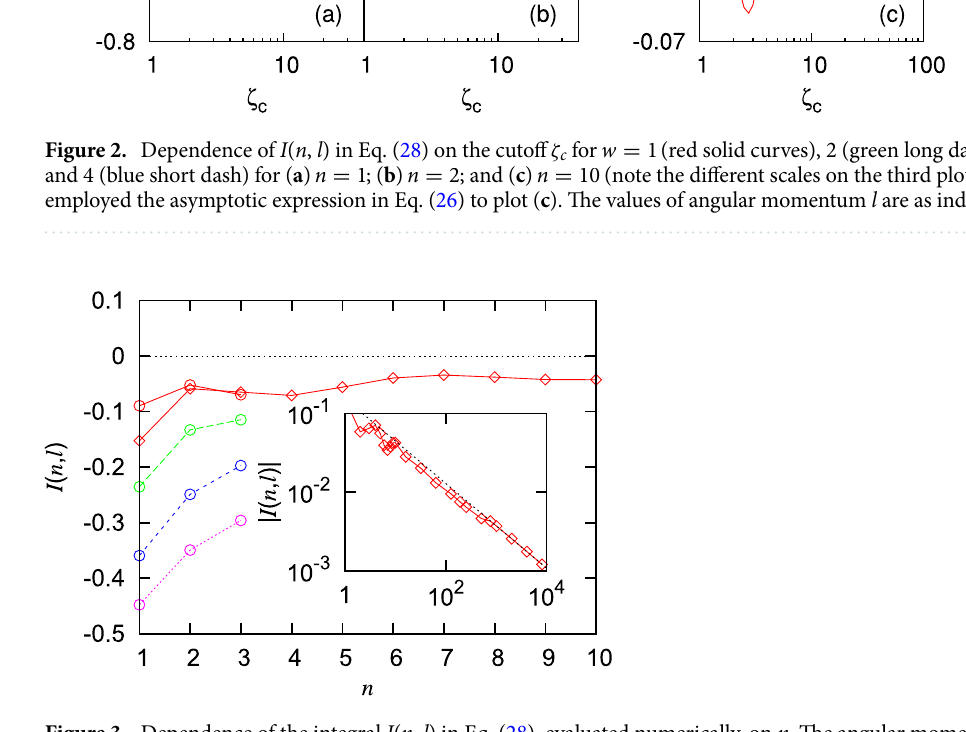
Figure 3. Dependence of the integral I ( n , l ) in Eq. (28), evaluated numerically, on n . The angular momenta of 2, 3, 4 and 5 (solid, long-dashed, short-dashed and dotted lines, respectively). Circles the instabilities are l = 1, 2 and 3. Diamonds were obtained using represent values obtained using the effective potentials, v n (ζ) for n = 2 case. The straight the asymptotic formula in Eq. (26). The inset shows the behaviour at very large n for the l = 800 . The fitting parameters are A l / n B l to the numerical data for n line in the inset is a fit of the form I ( n , l ) ≥ = 0.15 and B 2 0.54 A 2 ≈ ≈